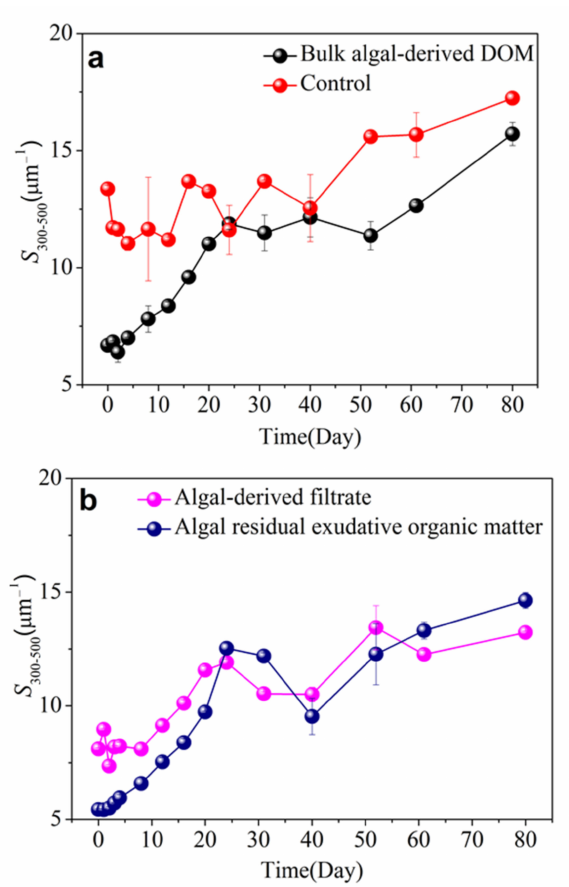
Figure 3. Dynamic changes in the chromophoric dissolved organic matter (CDOM) spectral slope for the 300–500 nm [S 300–500 ] interval during the 80-d degradation processes of the ( a ) bulk algal-derived DOM and natural lake water groups (as control) and ( b ) algal-derived filtrate and algal residual exudative organic matter